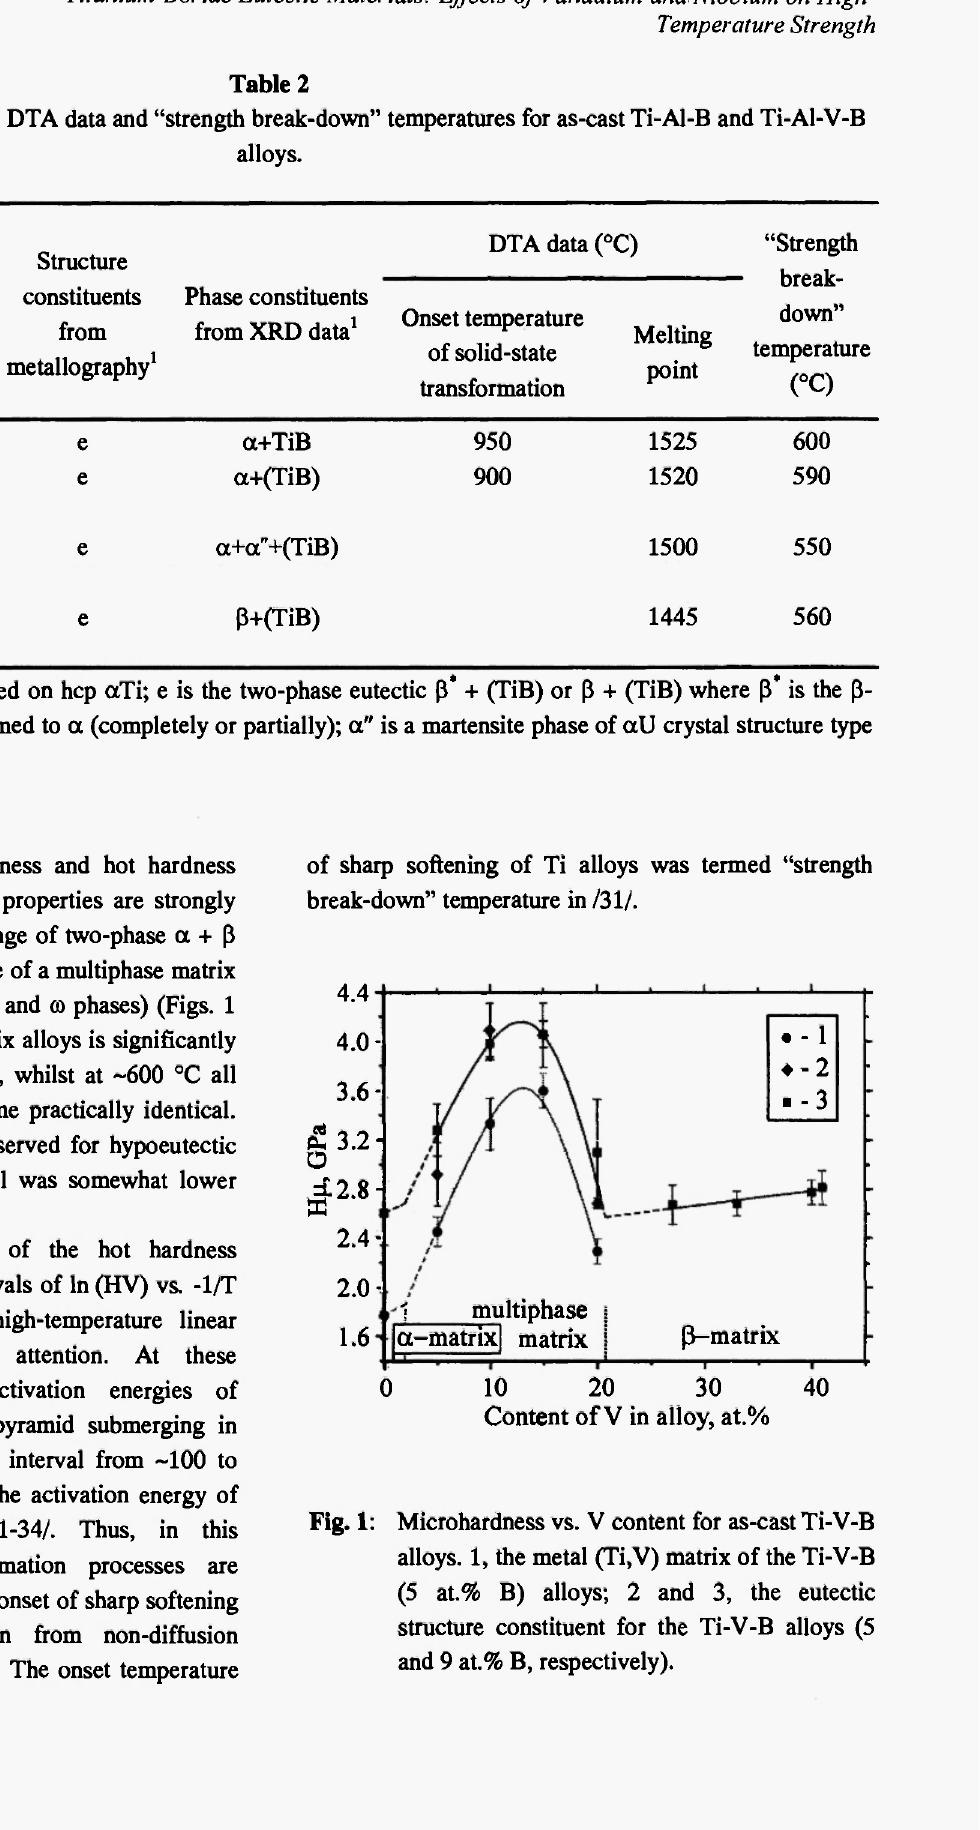
Fig. 1: Microhardness vs. V content for as-cast Ti-V-B alloys. 1, the metal (Ti,V) matrix of the Ti-V-B (5 at.% B) alloys; 2 and 3, the eutectic structure constituent for the Ti-V-B alloys (5 and 9 at.% B,